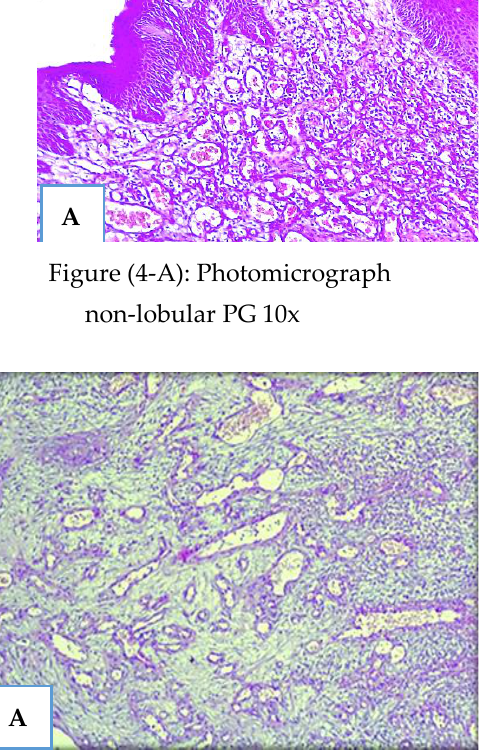
Figure (5-A): Photomicrograph non-lobular PG